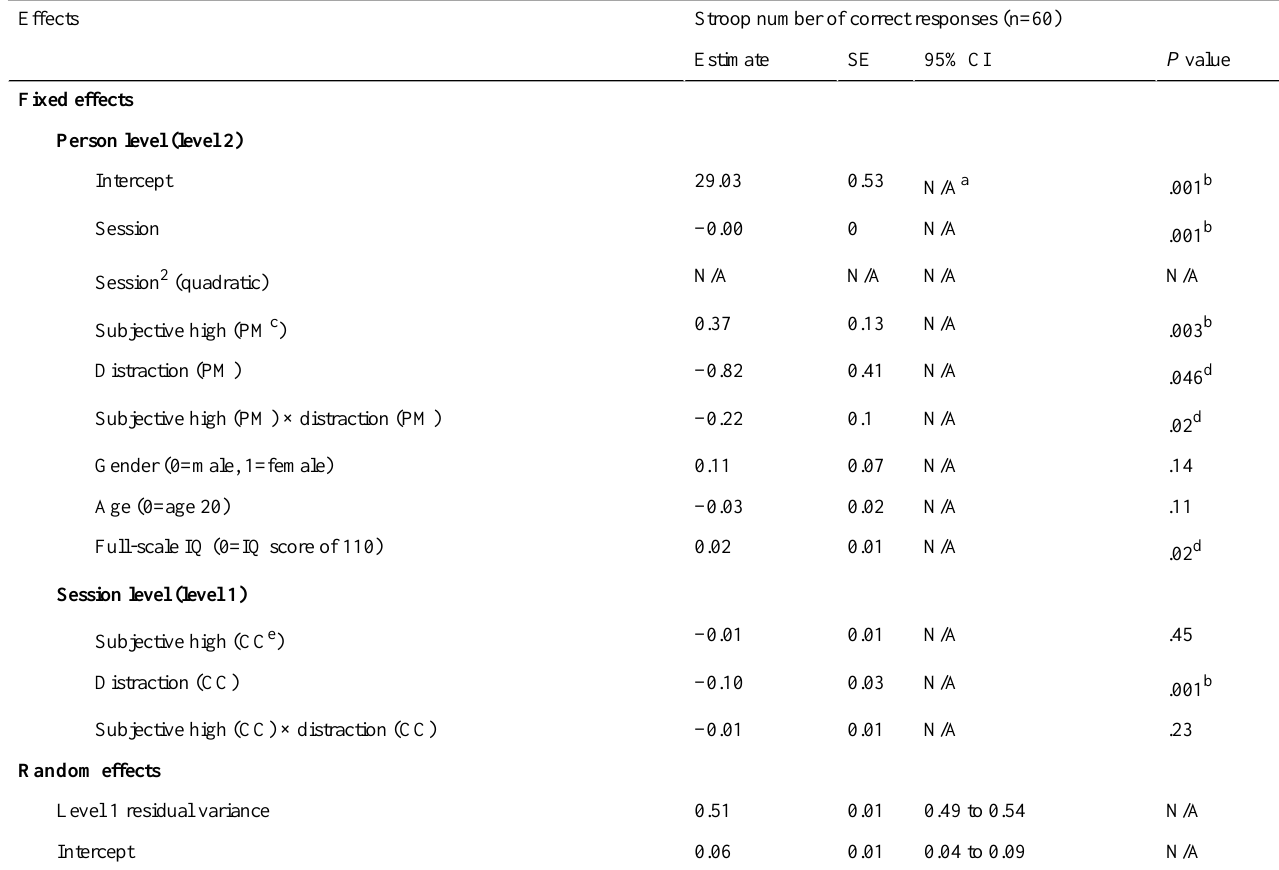
Table 7. Marijuana Stroop task: multilevel model of marijuana high in relation to number of correct